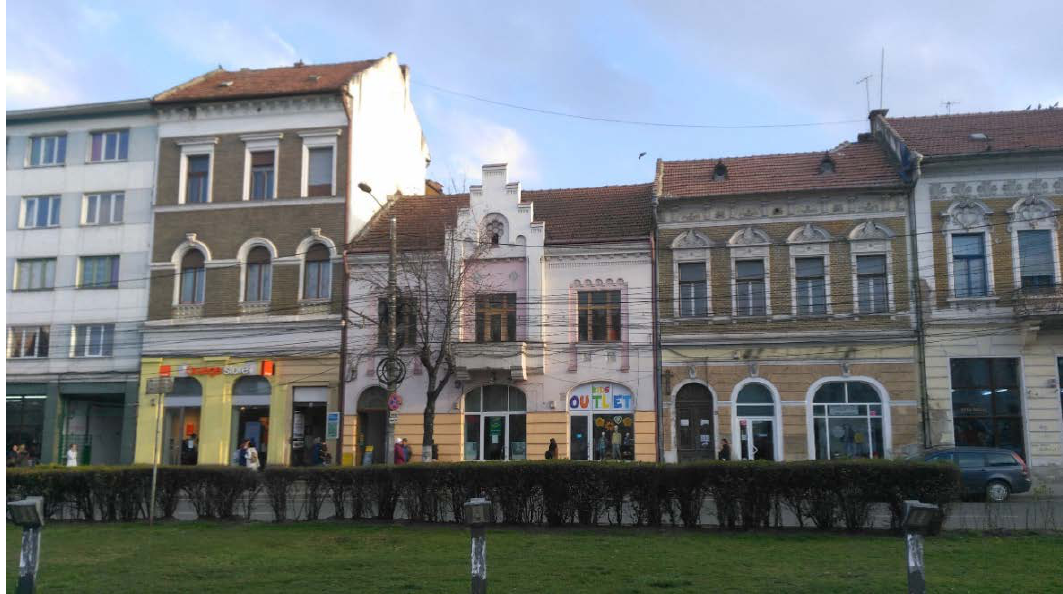
Figure 19: Old hybrid cultural landscape in Mihai Viteazul Square – A complex of buildings with heterogeneous architectural styles and typical urban function Source: Emanuel- Cristian ADOREAN,